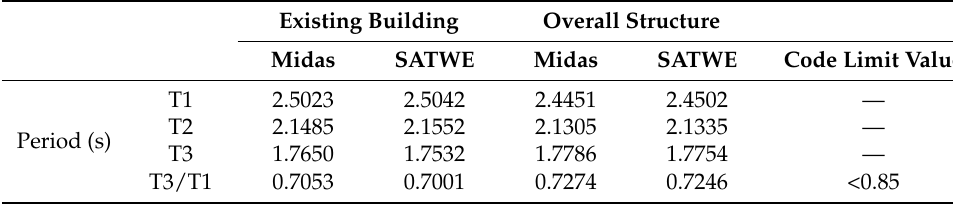
Table 3. Modal analysis data of structure.